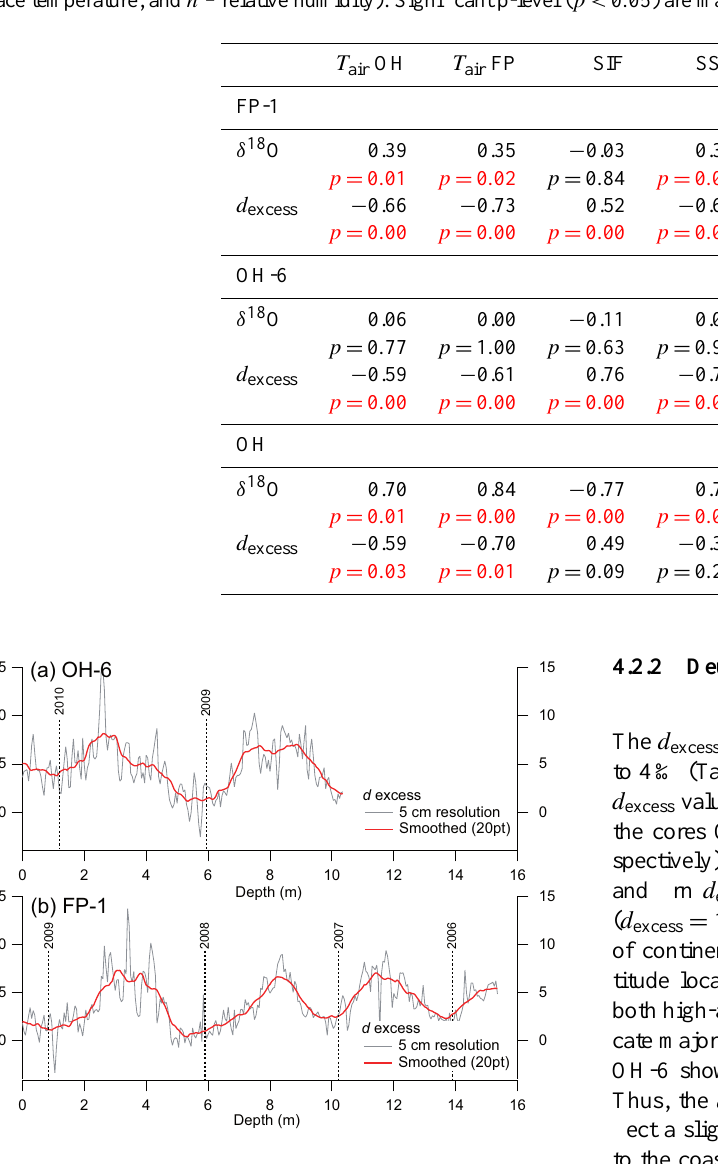
Table 4. Correlation matrix of mean monthly isotope values: resample of the high altitude firn cores (OH-6 and FP-1), precipitation (OH) and major seasonal forcing of meteorological variability identified for this region ( T air – air temperature, SIF – sea ice fraction, SST – sea surface temperature, and h – relative humidity). Significant p-level ( p < 0 . 05) are marked in red letters.